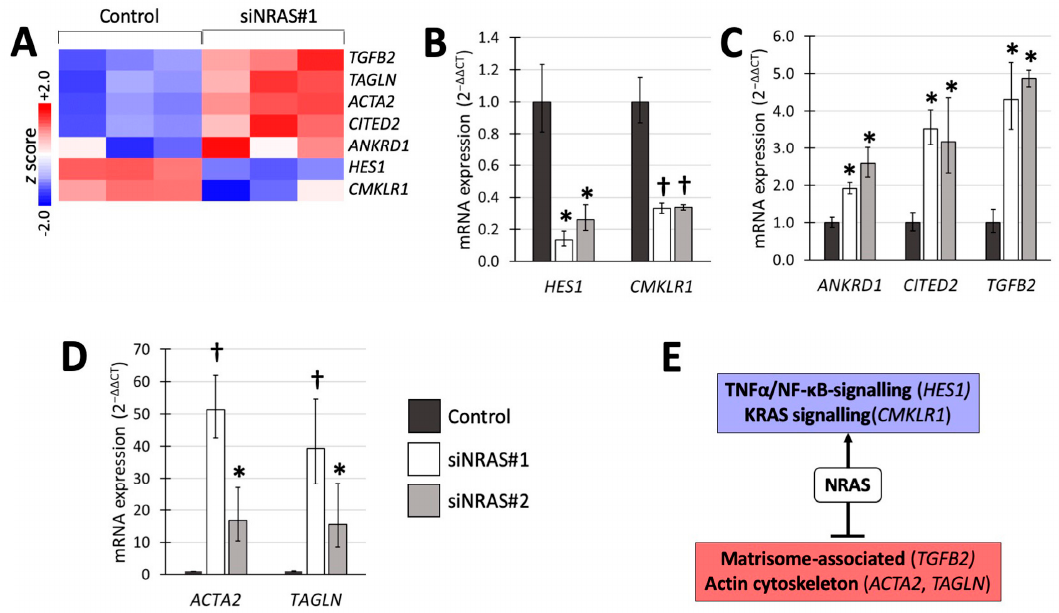
Figure 2. Transcriptomic analysis of siNRAS treatment versus control-transfection validated through RT-qPCR using two siRNAs (siNRAS#1 and siNRAS#2). ( A ) Heatmap displaying the z scores of the normalised expression level 2-logs for genes that were subsequently validated with RT-qPCR. ( B ) Genes downregulated by siNRAS, and present in the KRAS signalling or TNF α / NF- κ B signalling gene sets. ( C ) Upregulation of TGFB2 , present in the gene set of matrisome-associated proteins, and the genes ANKRD1 and CITED2 , by siNRAS. ( D ) Cytoskeleton-related genes upregulated by siNRAS and present in the EMT hallmark gene set. Results from 3 independent siRNA experiments are presented as fold change (2 − ∆∆ CT , mean ± standard deviation), and p values calculated with student’s T -test indicated as * (0.001 ≤ p < 0.05), or † ( p < 0.001). Bar colours as follows: Control, dark-grey; siNRAS#1, white; siNRAS#2, light-grey. ( E ) Summary indicating the interpretation of the siRNA experiment on transcriptomic data and validated mRNA expression changes: NRAS downregulates matrisomal genes and upregulates TNF α / NF- κ B and KRAS-related signalling.